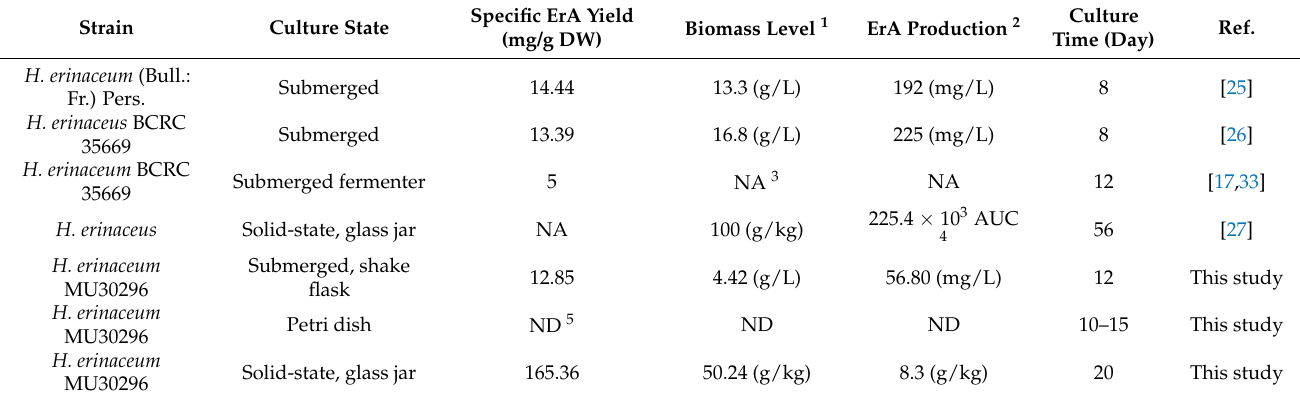
Table 2. Comparison of the ErA production in the